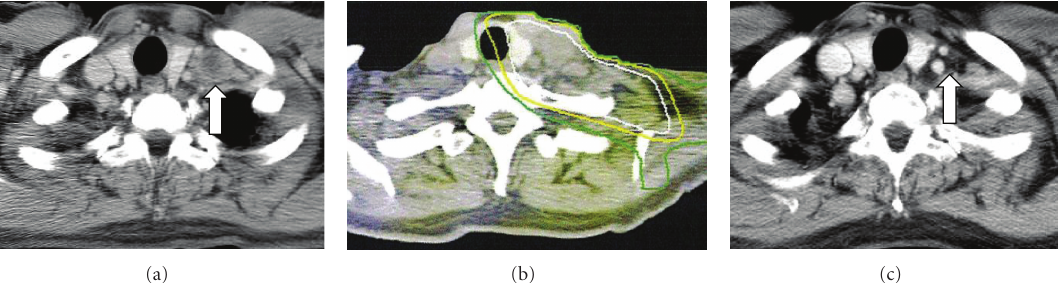
Figure 3: (a) CT of left supraclavicular lymph node metastases (arrow) before SBRT. (b) Dose distribution made with 4 coplanar beams for conventional radiotherapy. Isodose lines shows total doses (in 29 fracions) of 50 Gy, 40Gy, and 30 Gy, respectively, from innermost area. (c) CT at 1 months after the RT, showing complete response of the lesion (arrow).